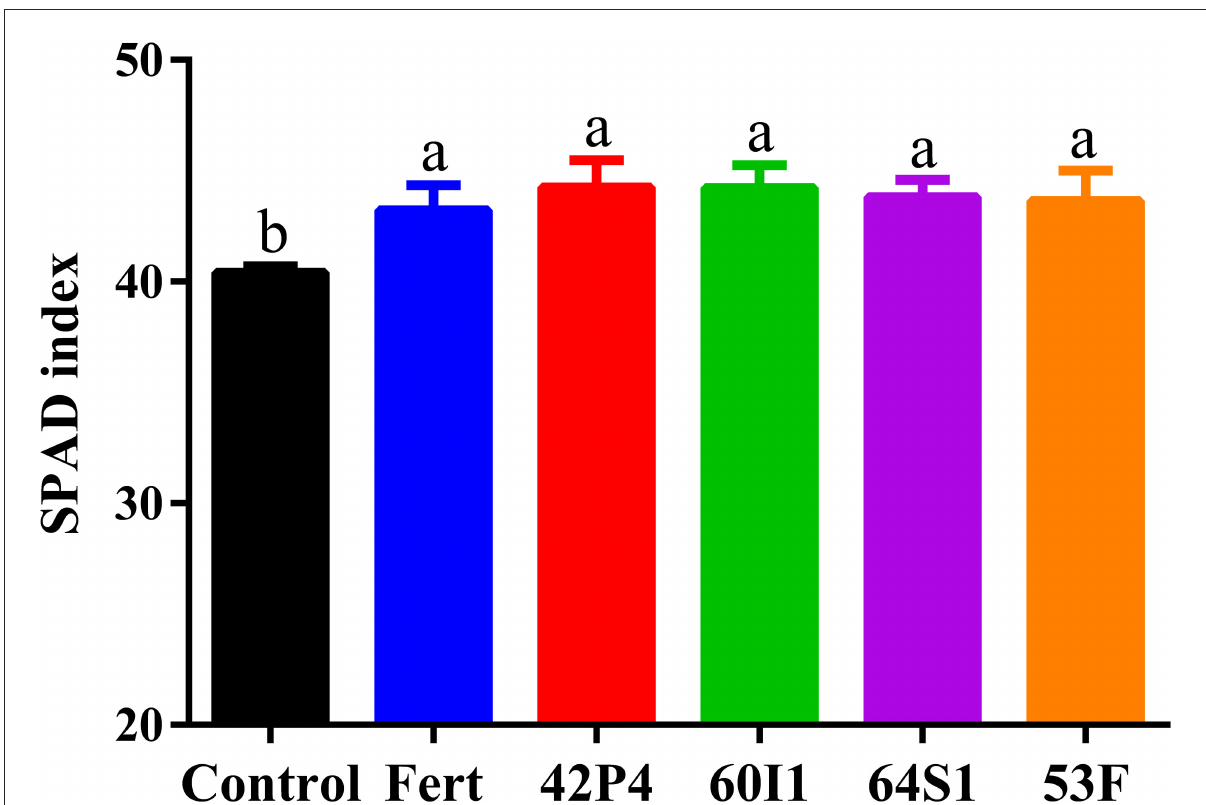
FIGURE5 Chlorophyll index (SPAD) of pepper plants of 90 day-old grown in pots and treated with: Fert: Fertilized; 42P4: Pseudomonas 42P4; 60I1: Cellulosimicrobium 60I1; 64S1: Enterobacter 64S1; 53F: Ochrobactrum 53F and Control (without bacteria). Data are presented as mean ± SEM of 10 independent biological replicates. Different letters indicate significant differences ( P < 0.0099) according to one-way ANOVA with Duncan’s multiple range test.